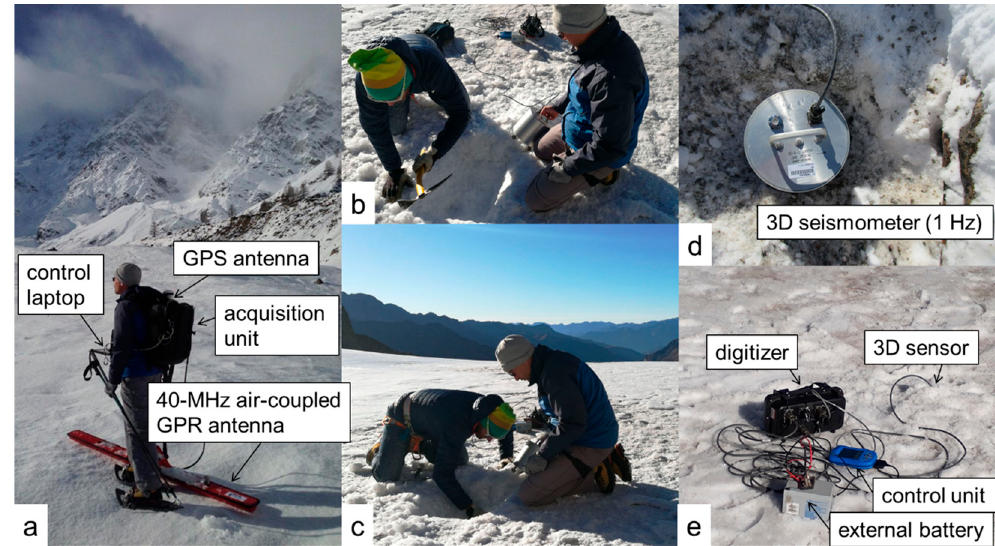
Figure 3. On-site operations for GPR and passive seismic acquisitions. ( a ) GPR instrumentation and acquisition setup. Note that the GPR antenna is not ground-coupled, but maintained a few centimeters above the ground surface during acquisition. ( b – e ) Installation of the broadband triaxial seismometer and passive seismic instrumentation details.